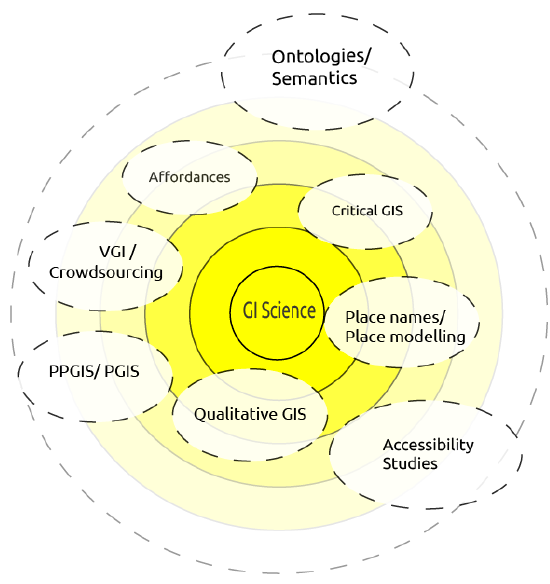
Figure 3. Repositioning the identified branches of place-based GIS in relation to the assessed uniqueness of GIScience.